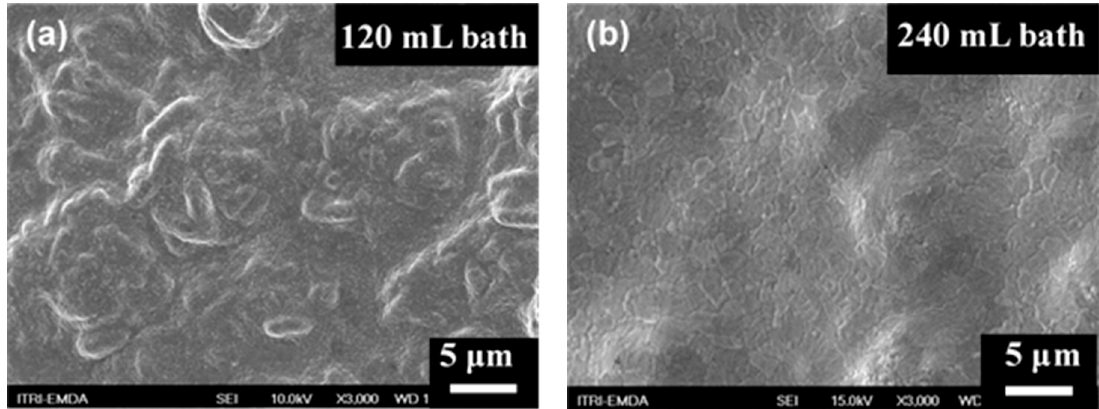
Figure 3. SEM plane view images of the membranes prepared using the same 6.75 mM concentration of the hydrazine addition but different volumes of bath: ( a ) 120 mL; ( b ) 240 mL.